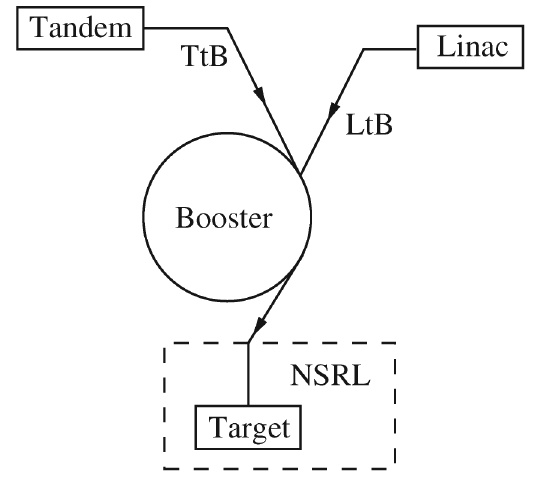
FIG. 1. Schematic diagram of the NSRL beam-transport line in relation to the AGS Booster synchrotron, the LINAC that pro- vides a proton beam, and the Tandem accelerator that supplies beams of many different ions species. The Tandem to Booster (TtB) and the LINAC to Booster (LtB) transfer lines are shown in the figure.